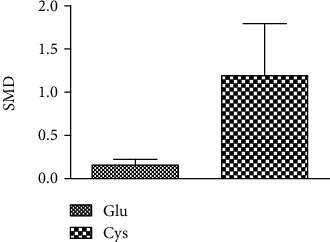
Meta-analysis of the effects of arsenic on Glu, Cys, and Gly in vitro. SMD: standardized mean difference. The P value of the Glu's overall effect test is 0.96. The P value of the Cys's overall effect test is 0.19. When P < 0.05, the difference was considered statistically significant.